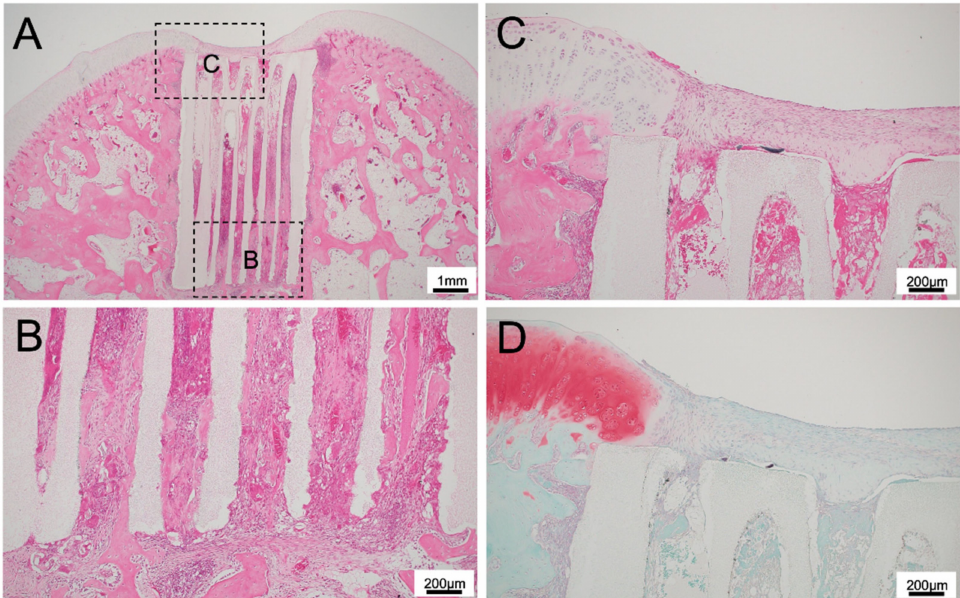
Figure 4. ( A ) Histological finding of 300TCP with TGF- β with Matrigel at low power magnification. ( B , C ) Histological finding of 300TCP with TGF- β with Matrigel at high power magnification. Bone formation from existing bone was observed in the area where the TCP was in contact with existing bone marrow. The superficial layer of TCP was covered with fibrous connective tissue, and cartilage tissue formation was observed in some areas. ( D ) Safranin O staining showed slight cartilage formation in the superficial layer of the